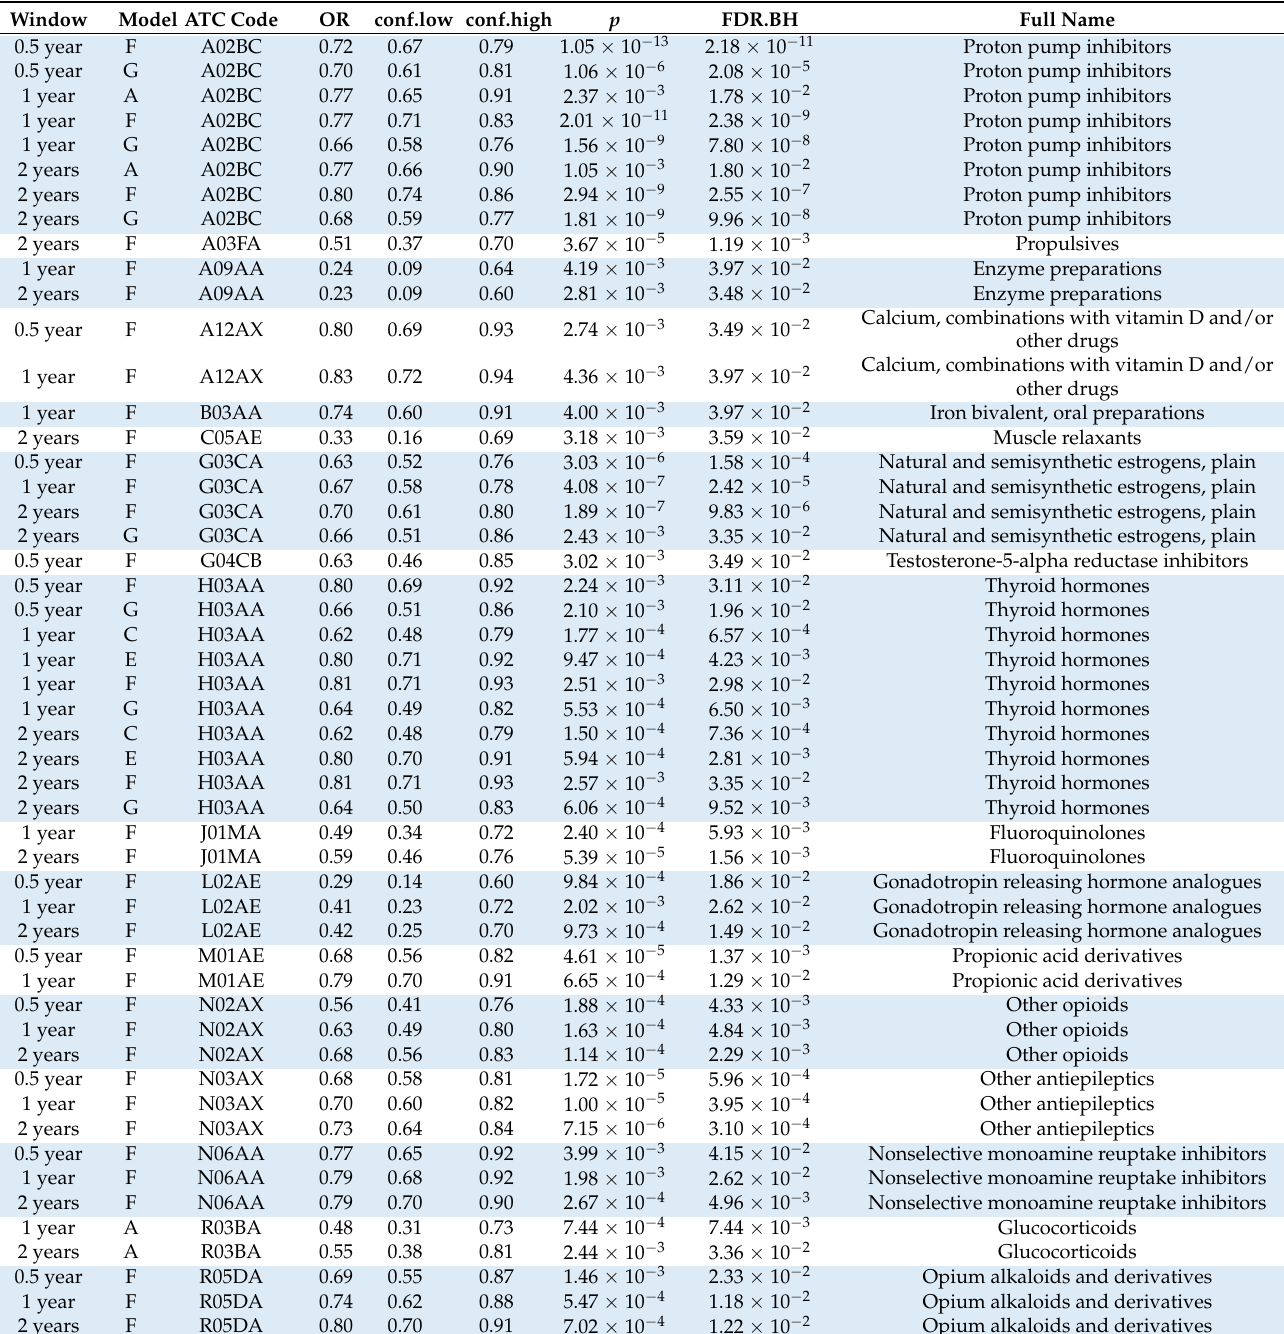
Table 6. Other drugs with significant protective associations (limited to FDR < 0.05) within time windows of 6, 12, and 24